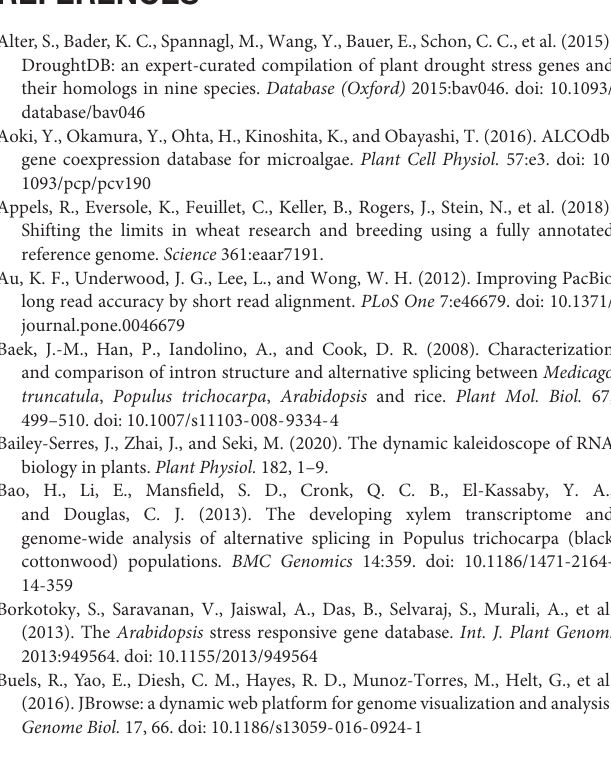
Supplementary Figure 5 | MR values filtering for stress co-expression network. (A) Assessment of PCC co-expression network. (B) Assessment of MR co-expression network. Supplementary Figure 6 | The profile of alternative polyadenylation and alternative transcription initiation. (A) All APA genes in control and stress condition. (B) APA genes under stress and control in leaf. (C) APA genes under stress and control in root. (D) APA genes under stress and control in stem xylem. (E) All ATI genes in control and stress condition. (F–H) ATI genes in leaf, root and stem xylem compare control and stress. Supplementary Figure 7 | Domain structure diagrams for RRM-domain protein. Supplementary Table 1 | Sequencing data used in this study. Supplementary Table 2 | P. trichocarpa stress response genes. Supplementary Table 3 | Values for an example of ROC analysis. Supplementary Table 4 | ChIP-seq peaks. Sheet 1 are peaks from transcription factors of ARK1, ARK2, BLR, PCN, and PRE. Sheet 2 are 9,360 differential